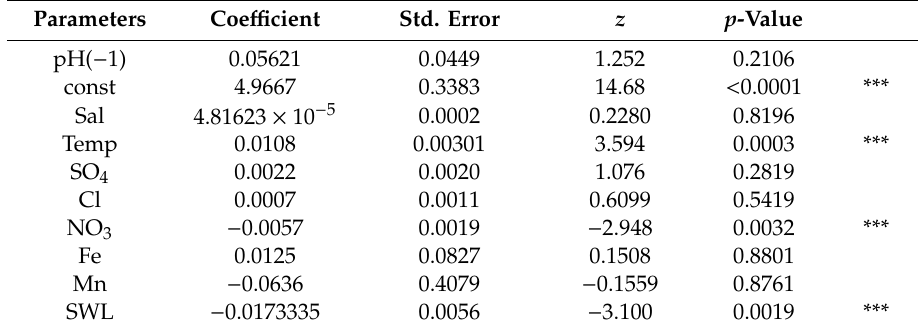
Table 3. Multiple regression statistical model with dependent variables against the pH as independent variables for selected dry season groundwater quality parameters.